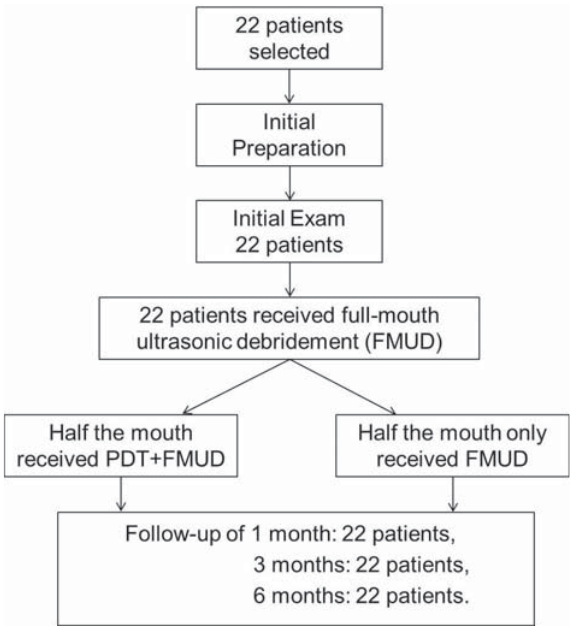
Figure 1- Flowchart of study Table 1- Mean (standard deviation) of the variables VPI and GBI considering the entire mouth, at different time intervals